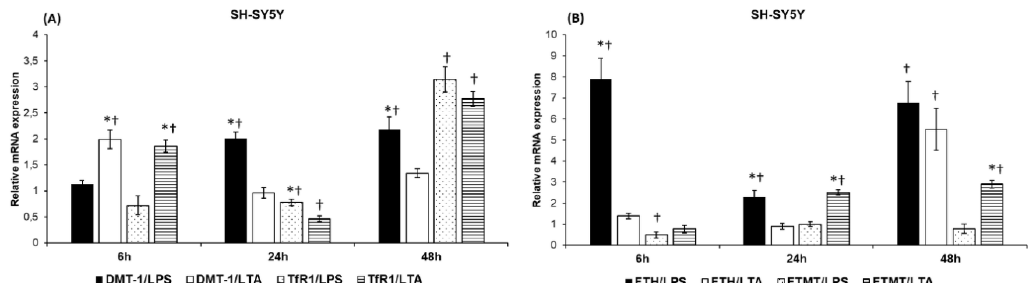
Figure 2. Effects of LPS and LTA treatments on the mRNA expressions of iron uptake and iron storage genes in SH-SY5Y cells. Real-time PCR was performed with the SYBR green protocol using gene-specific primers. β -actin was used as a housekeeping gene for the normalization and relative expression of controls was considered as 1. The mRNA expressions of the treated cells were compared to their appropriate controls (6 h, 24 h, or 48 h). ( A ) mRNA expression levels of DMT-1 and TfR1 of LPS- and LTA-treated SH-SY5Y cells. ( B ) mRNA expression levels of FTH and FTMT of LPS-and LTA-treated SH-SY5Y cells. The columns represent mean values and error bars represent standard errors of the mean (SEM) of three independent determinations. Asterisk indicates p < 0.01 between LPS and LTA treatments. Cross marks indicate p < 0.01 compared to the untreated controls.